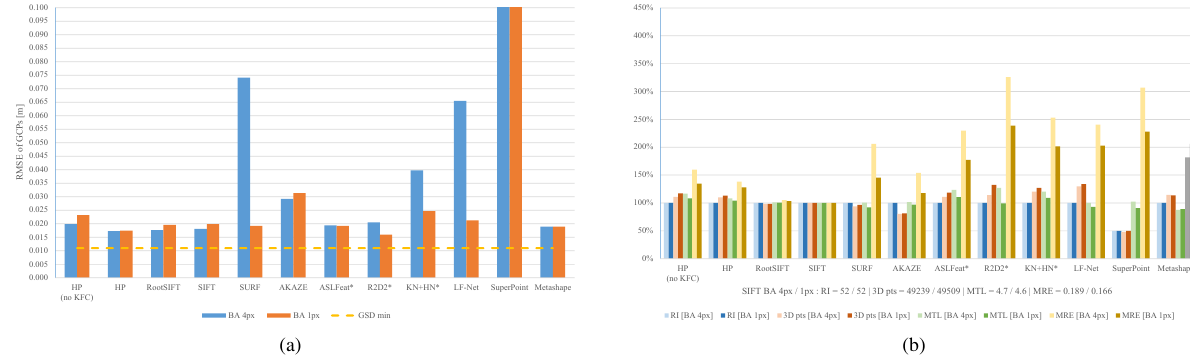
Figure 6. Ventimiglia Theatre Nadiral dataset: (a) RMSEs of the CPs and (b) BA statistics as percentages with respect to SIFT values (OPENCV camera model with no PP post-refinement, mTL=3). The min GSD is reported with respect to the downsampled images. The * superscript indicates that input images were manually rotated as the considered learning-based method is not invariant to camera rotation.